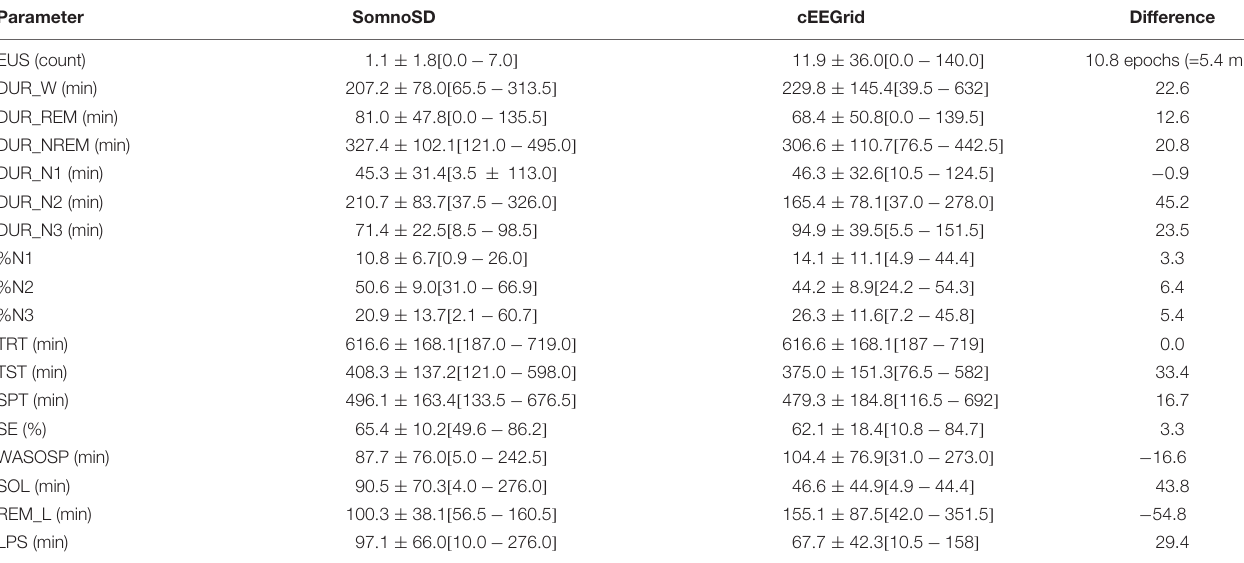
TABLE 2 | Means, standard deviation, and range for sleep parameters.